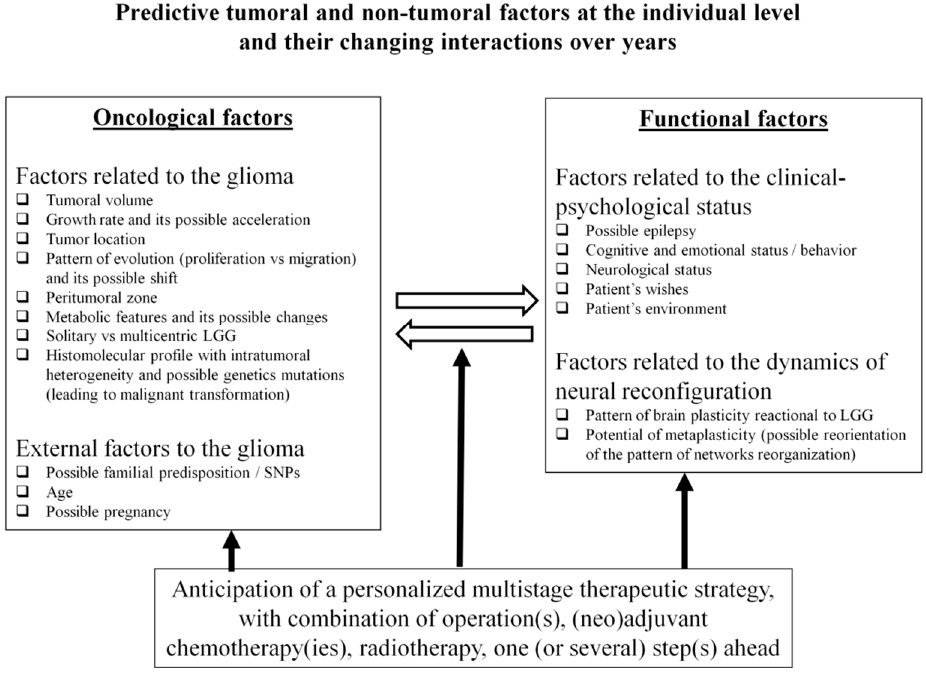
Figure 1. Predictive tumoral and non-tumoral factors at the individual level and their changing interactions over years.